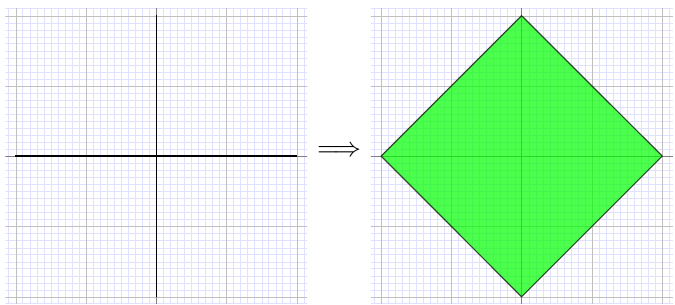
which defines the envelope of holomorphy D ( X 0 2